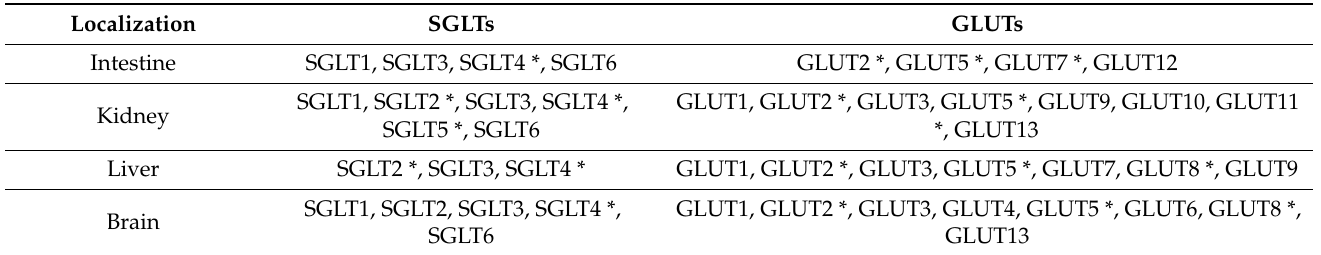
Table 2. Major sodium–glucose linked transporters (SGLTs) and facilitated diffusion glucose trans- porters (GLUTs) in several mammals’ organs expression. Transfer for glucose and galactose include possibly the same transporters. Fructose requires other transport proteins (pointed by